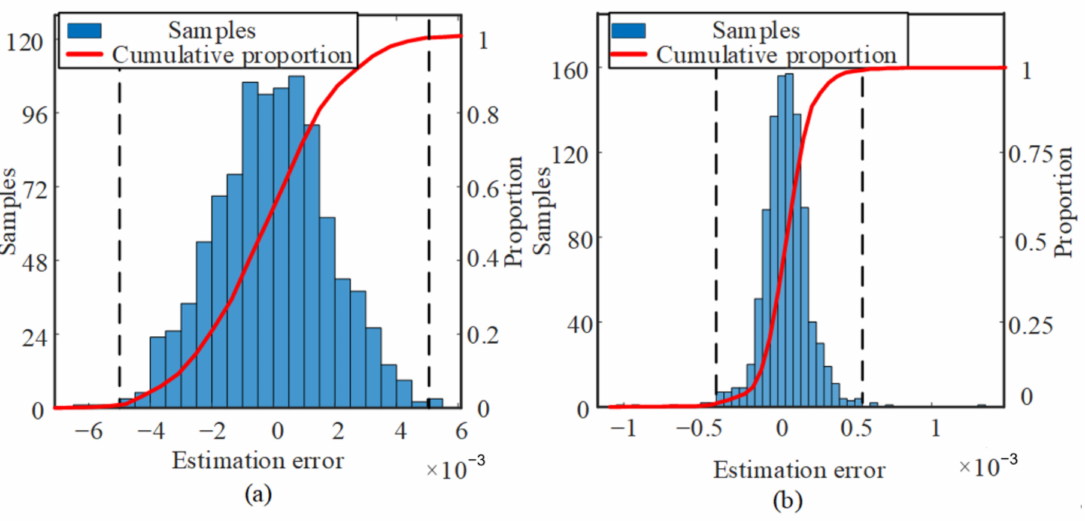
Figure 11. Error distribution of sensor fault severity degree estimation: ( a ) error distribution of gain-variation fault; ( b ) error distribution of zero-offset fault.